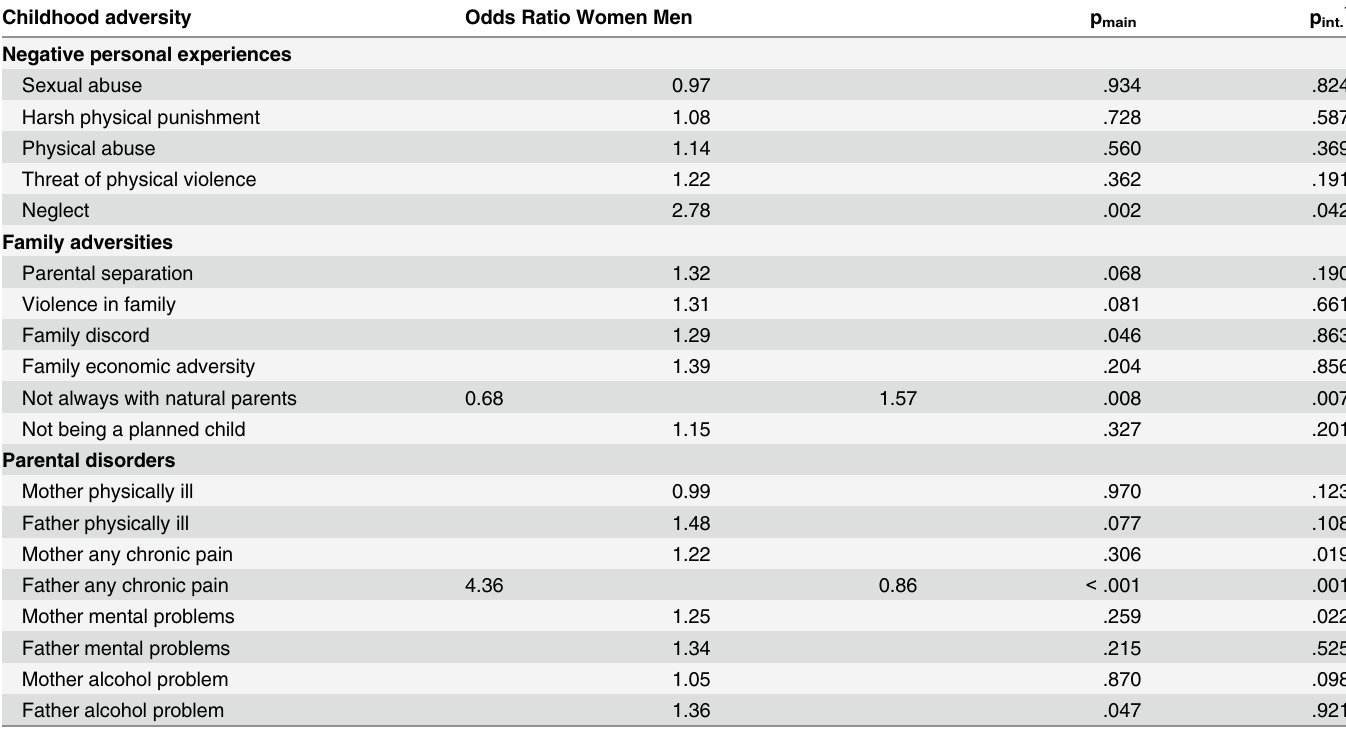
Table 4. Adjusted associations between headache and childhood risk